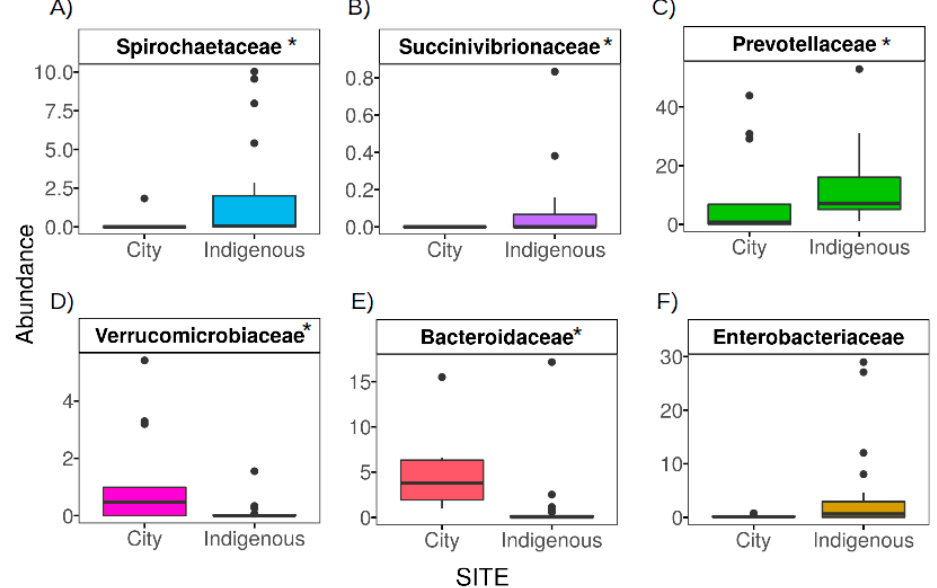
Figure 5. VANISH and BloSSUM GM boxplots from México City (City) and indigenous (Me´phaa) communities. VANISH and BIoSSUM boxplots show family taxa between México City and Me’phaa children’s fecal microbiota. The VANISH taxa are composed of Spirochaetaceae, Succinivibrionaceae, and Prevotellaceae families ( A – C ); the BIoSSUM family taxa are Verrucomicrobiaceae, Bacteroidaceae, and Enterobacteriaceae ( D – F ). * Corresponds to significant differences between communities ( p < 0.01).